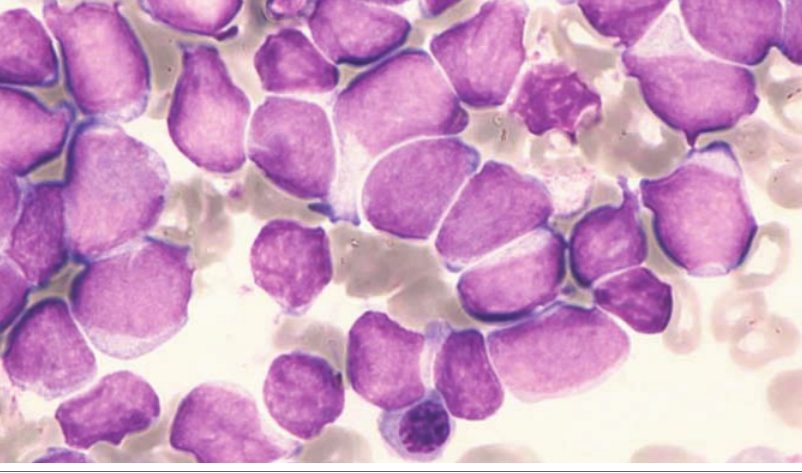
Figure 1. Bone marrow aspiration revealed morphological findings compatible with ALL- L2 (May-Giemsa staining, 1000×).